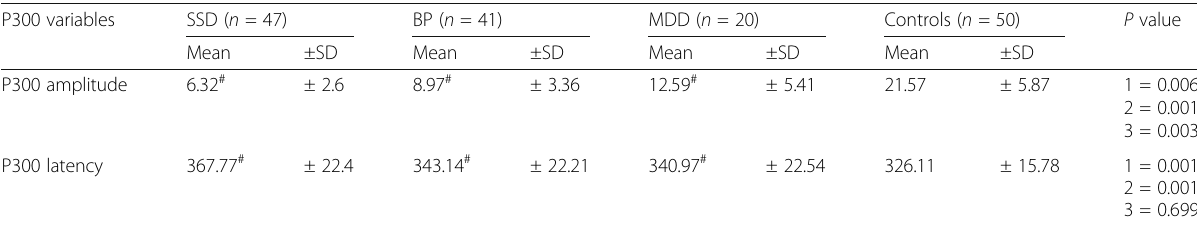
Table 3 Comparison of P300 variables among first-episode psychosis diagnostic groups and control P300